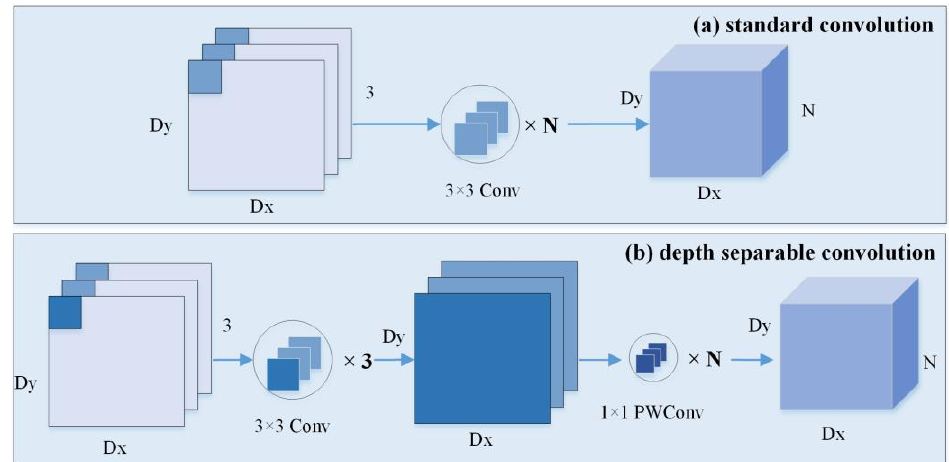
Figure 8. Comparison of standard convolution and depth separable convolution.